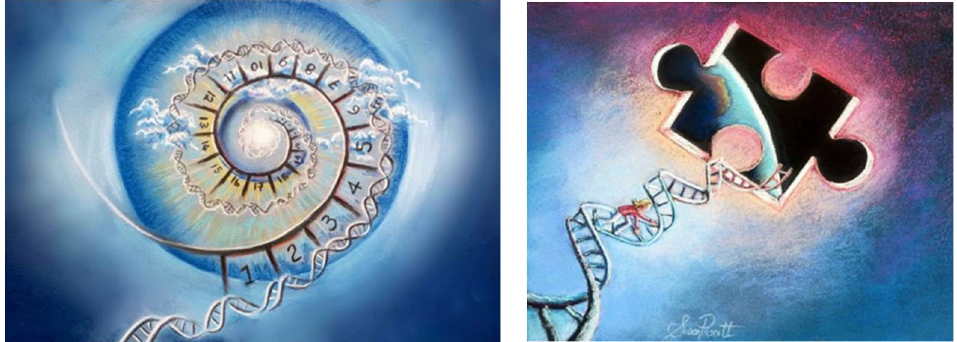
Figure 4. Benefits now and for generations to come: efforts to promote wise reasoning, attitudes and behaviors will have immediate and long-term social and biological implications for individuals and societies, and the health of people, places, and planet for generations to come (artwork by S.L.P.).